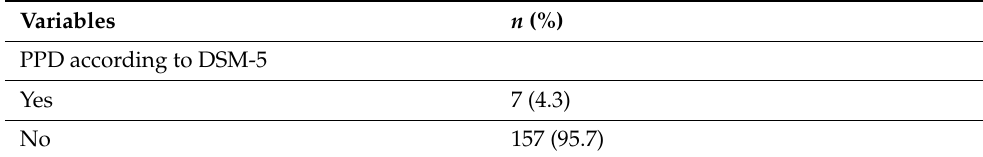
Table 10. Prevalence of PPD at one month post-partum.